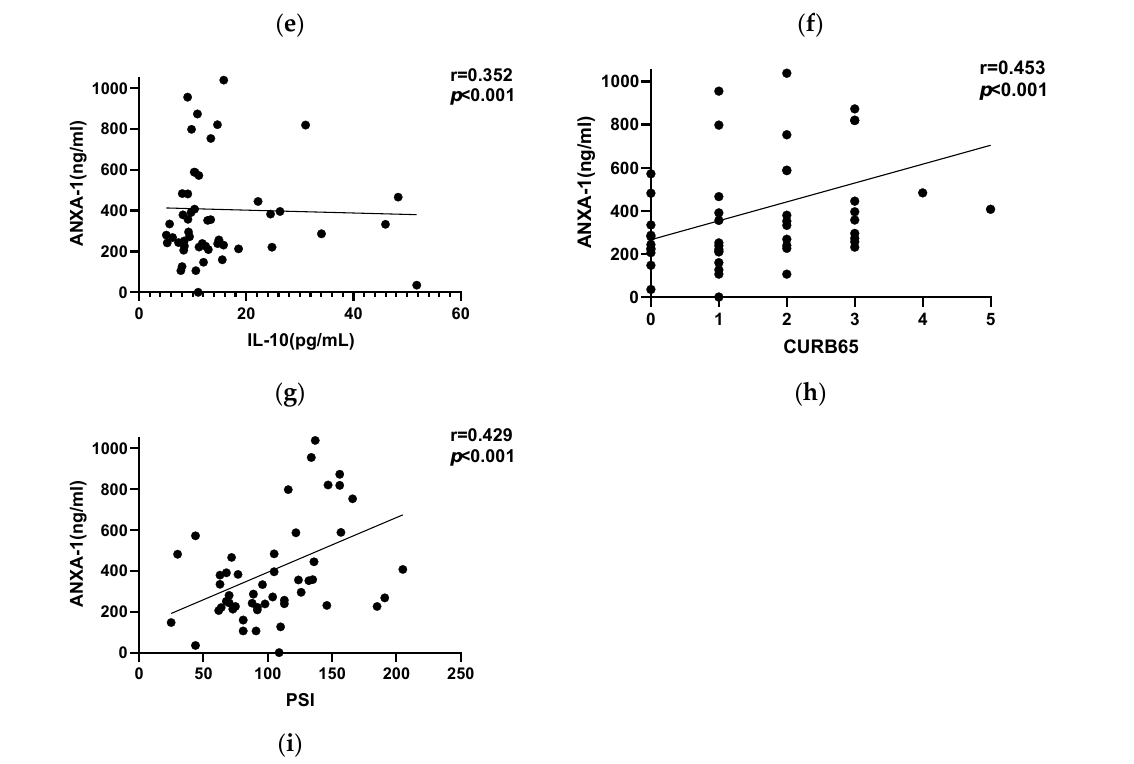
Figure 3. Correlation between AnxA1 level with multiple clinical indicators in 52 patients with CAP.